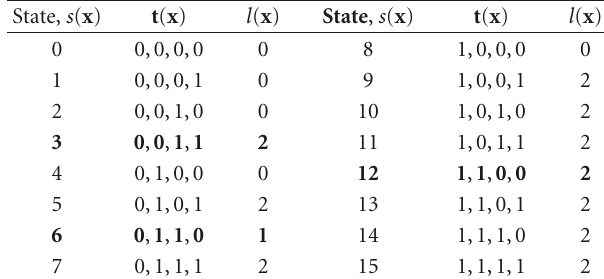
Table 1: The temporal discontinuity model for the framework.